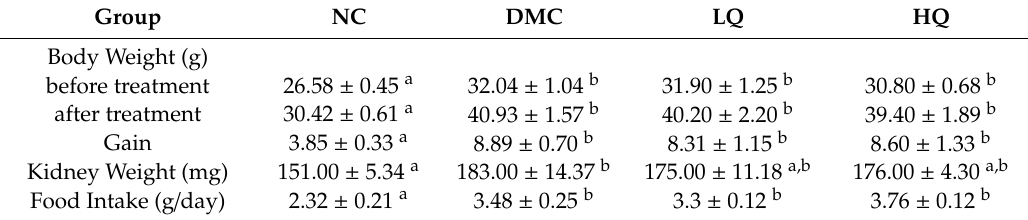
Table 2. E ff ect of QAE on body weight, kidney weight, and food intake in type 2 diabetes mellitus (T2DM) mice. Group NC DMC